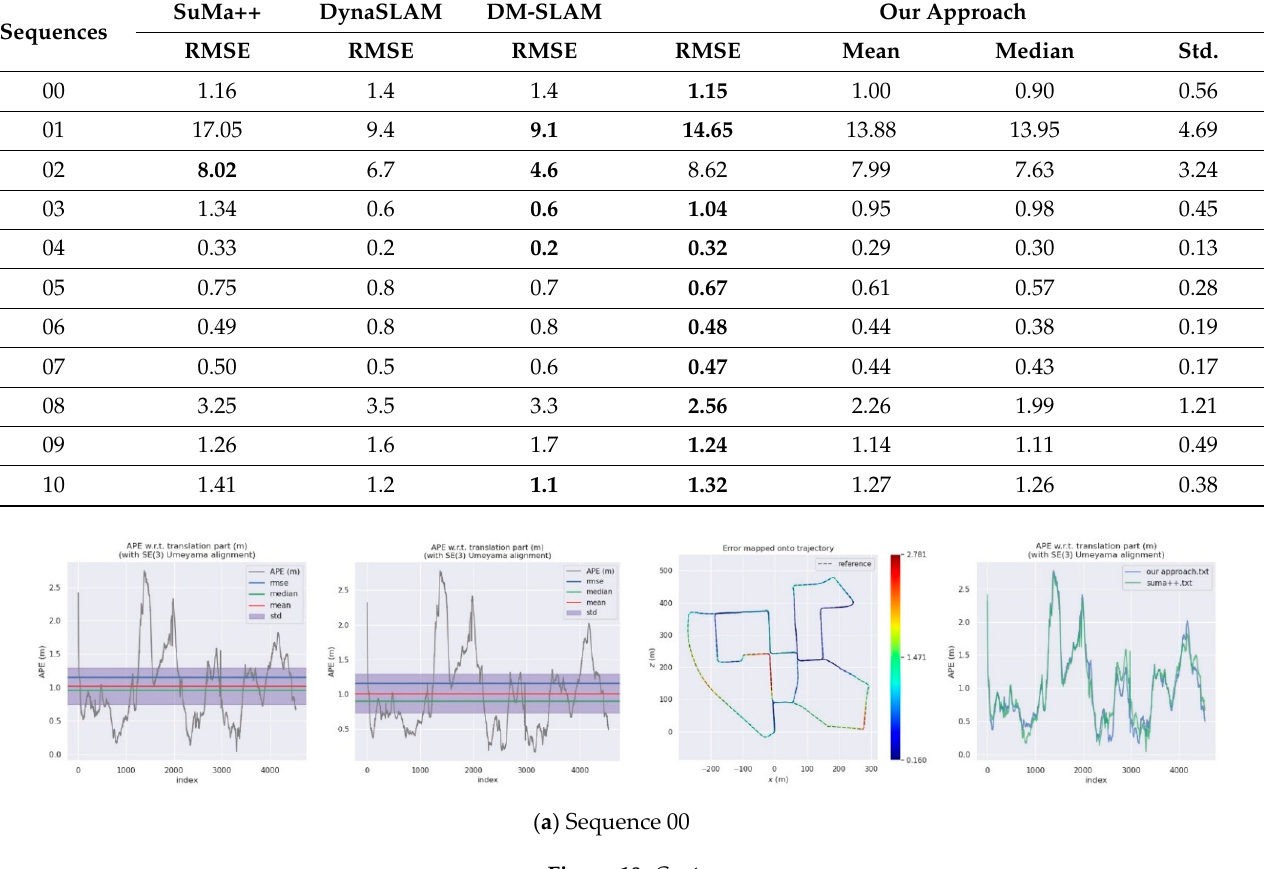
Table 2. Comparison of APE for translation part (Unit: m).